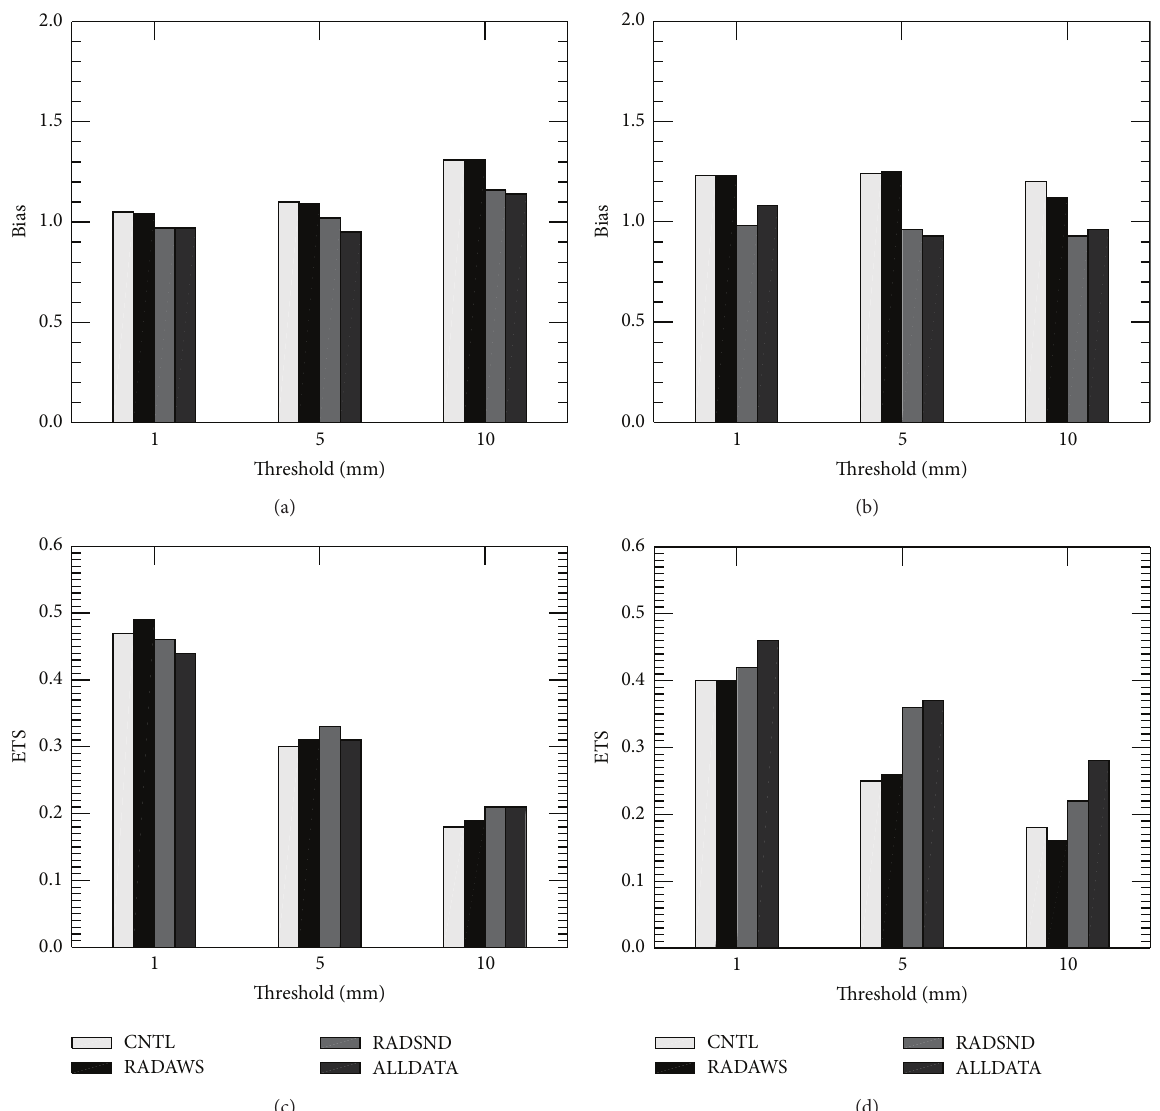
Figure 14: Bias score and ETS for 6h accumulated precipitation with the thresholds of 1, 5, and 10mm for case 20110715 from the four experiments. Bias for (a) the first 6 h and (b) the latter 6h precipitations and ETS for (c) the first 6h and (d) the latter 6h